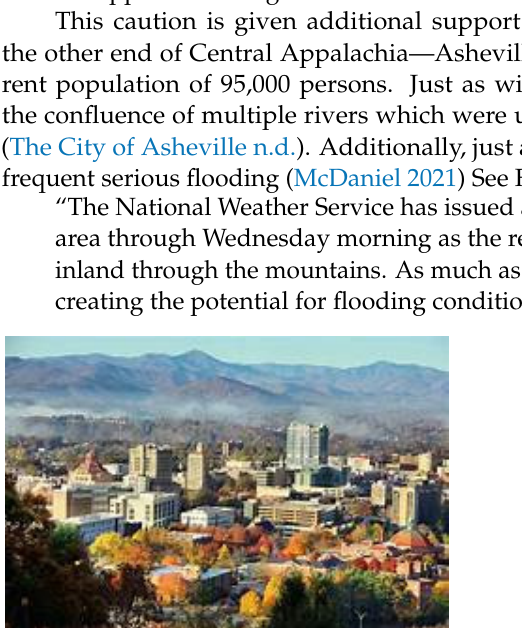
Figure 5. Asheville during the 2022 flood. 2.2. Potential Power Sources Due to Appalachia’s unfortunate history as a coal-, natural-gas-, and oil-producing, region which contributed significantly to the current level of global warming, it is important to avoid using energy sources which are carbon-based. Wind power is possible as an energy source in the region, but the mountainous terrain makes it relatively inefficient (Appalachian Power n.d.a). Similarly, solar panels are currently in use on buildings and homes in the Appalachian region and may be especially useful as a supplemental energy source (Appalachian Power n.d.b). However, the paucity of large, flat, open spaces that could support solar installations, such as those found in the California, Arizona, Colorado, New Mexico, and Hawaii, makes this type of energy less viable in Appalachia. Fortunately, there is an available clean energy source that will be ample for those re- locating to the Central Appalachian Region— hydro-powered generators . Just as out-of- control rivers and streams in the region cause flooding and erosion, these same waterways can be used to power generators capable of producing enough electricity to support communities of up to 50,000 persons (Calvin and Risch 2006). These are not the concrete water-storage-and-spillway dams typical of the traditional Tennessee Valley Authority (Tennessee Valley Authority n.d.). However, as will be described below, hydropower generators are placed either in flowing rivers or in existing water reservoirs. Thus, they cause no disruption to the existing eco-system. 2.3. Hydro-Powered Generators In the discussion below, various types and configurations of hydro-powered generators are described and discussed in terms of their ability to supply electricity to Central Appalachian communities. Hydropower Turbines. There are two primary types of hydropower turbines: reaction and impulse. The type of hydropower turbine selected for a project is based on the height of the standing water to be input to the generator—referred to as “head”—and